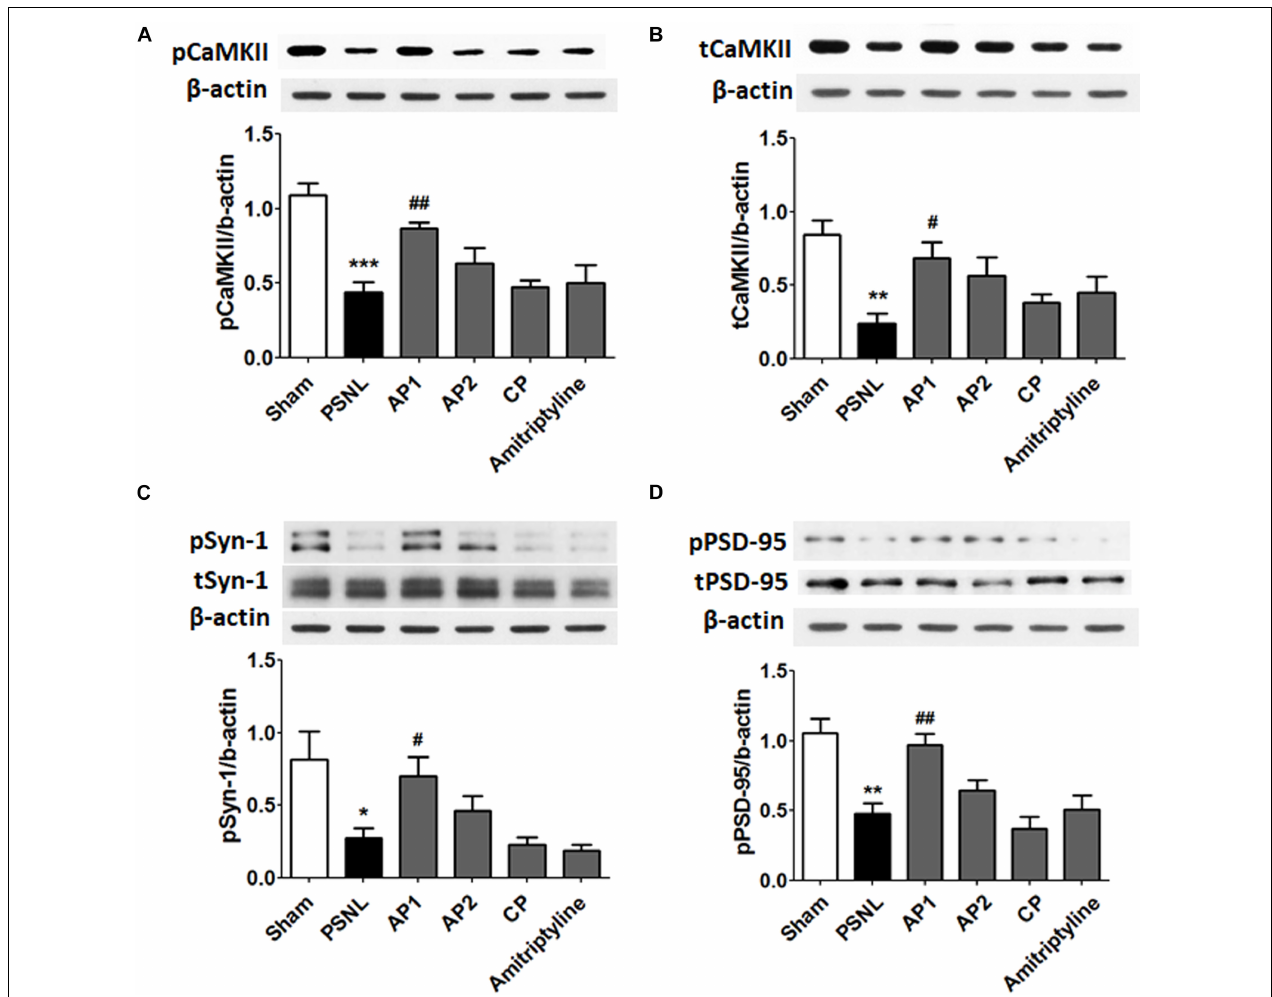
FIGURE 7 | Effects of acupuncture on the expression levels of CaMKII and synaptic proteins. These results show the changes in protein levels of hippocampal CaMKII ( A,B ; n = 5/group) and synaptic proteins ( C,D ; n = 4/group) after administration of acupuncture (AP1, AP2, or CP) or amitriptyline (10 mg/kg, i.p.) for 28 consecutive days. ∗∗ p < 0.01, ∗∗∗ p < 0.001 compared to the Sham group. # p < 0.05, ## p < 0.01 compared to the PSNL group. Data are expressed as the mean ± SEM. The same β -actin value was used (A,C ; B,D) . AP1, acupuncture 1 (GB30 and GB34); AP2, acupuncture 2 (HT7 and GV20); CP, control